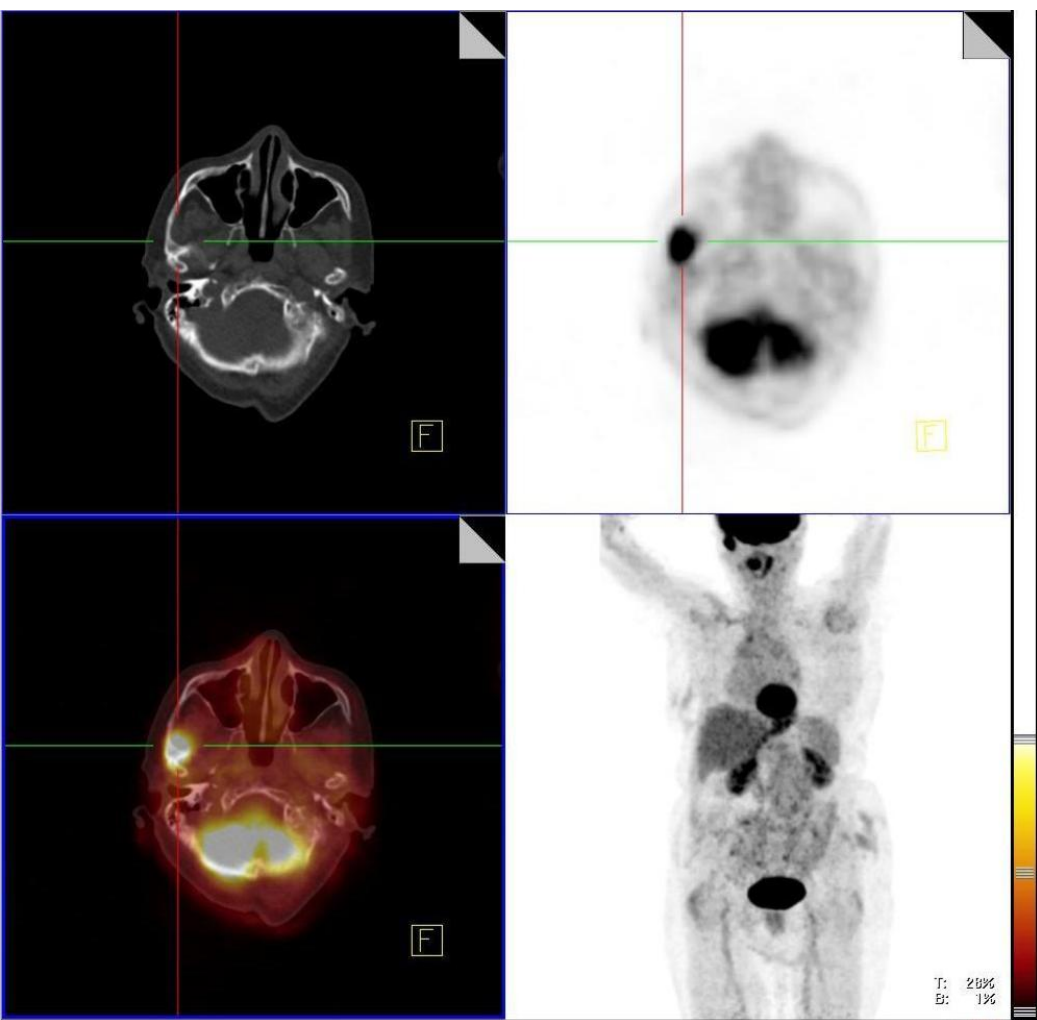
Figure 3. Active sarcoidosis present in right zygomatic bone.